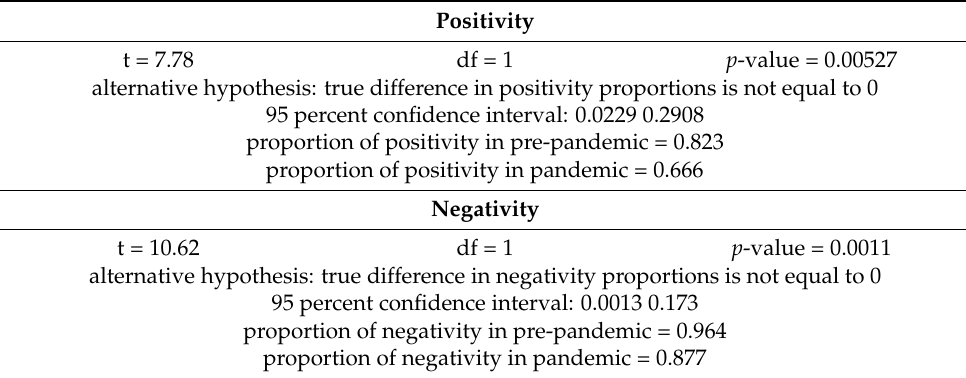
Table 2. The empirical results of two-sample difference-of-proportions t Table 1. The empirical results of Welch two-sample t-test.